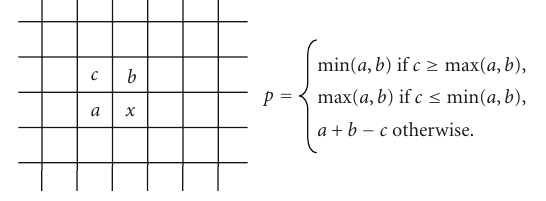
Figure 1: Context for predicting the pixel x